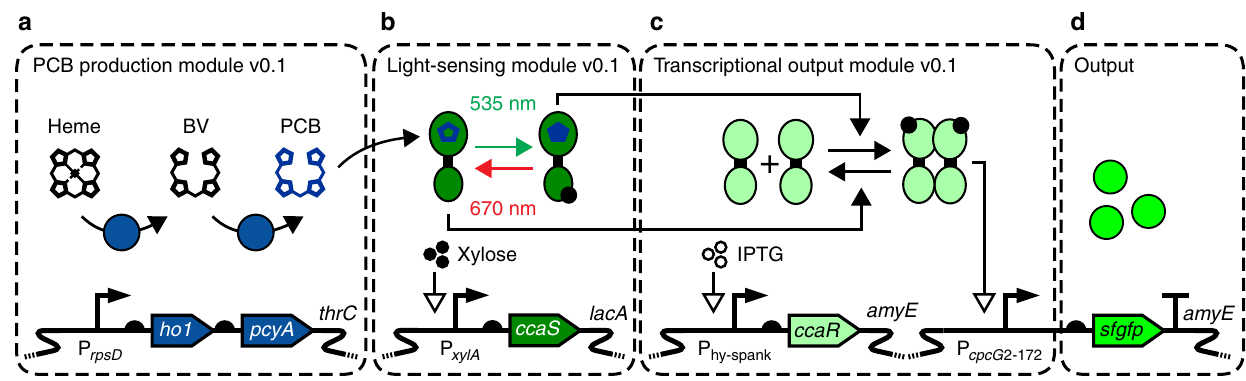
Fig. 1 B. subtilis CcaSR v0.1 device schematic. The fi rst implementation of B. subtilis CcaSR, comprised of a PCB production module v0.1, b light-sensing module v0.1, and c transcriptional output module v0.1. d System activity is measured by an sfgfp reporter. Genetic diagrams are shown at the bottom, and proteins, prosthetic groups, and expected interactions are represented at